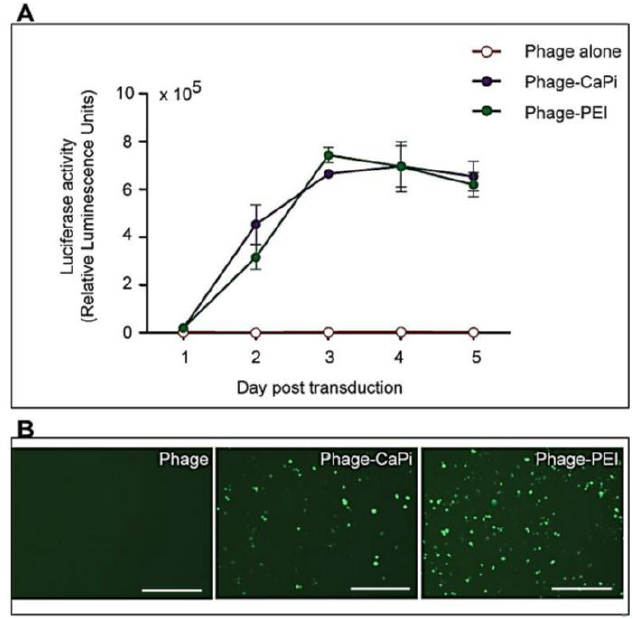
Figure 3. Kinetic study of phage combined with calcium phosphate and PEI in HEK293 cells. HEK293 cells were treated with phage vectors carrying the Luc or GFP reporter genes, premixed with optimized ratios of calcium phosphate or PEI and compared to phage vector alone. ( A ) The luciferase assay was performed daily over a time period of five days following vector transduction. Results represent the average relative luminescence units of triplicate wells and error bars represent the standard error of the mean; ( B ) Representative images showing GFP expression mediated by phage-CaPi and phage-PEI in HEK293 cells, taken at day 5 post-transduction. Scale bars = 500 µm.